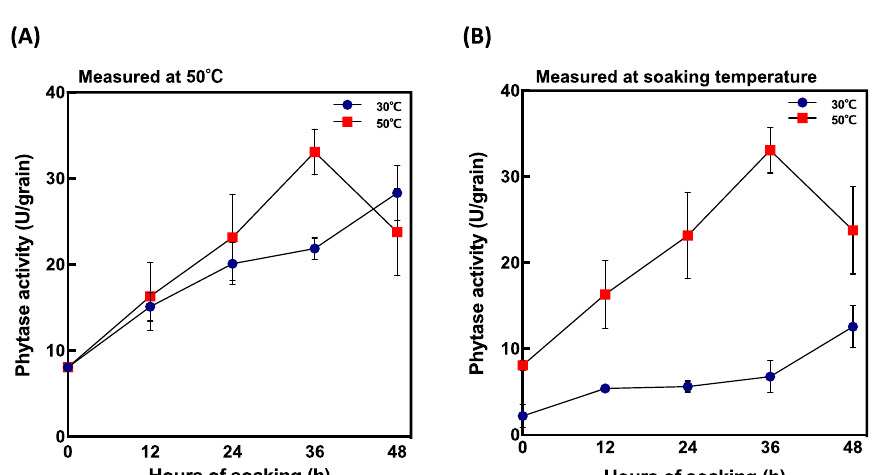
Figure 5. Changes in phytase activity in short periods after soaking at 30 ◦ C and 50 ◦ C. ( A ) phytase activity measured at 50 ◦ C and ( B ) phytase activity measured at soaking temperature. Data are shown as the mean ± standard deviation from 3–5 replicates.